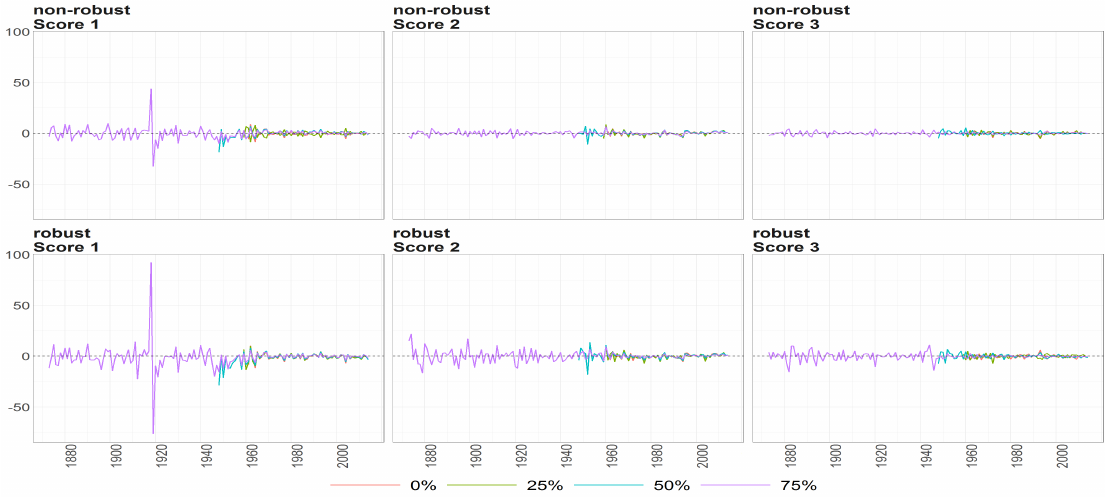
Figure 15. The scores (y axis) over time (x axis) obtained using PPCA for female population of Life Expectancy at Birth. Colours of lines correspond to the scores calculated on subsample where are different levels of maximum missing values per observation (0%, 25%, 50% and 75%, refer to legend). The plots placed in the first row correspond to the results using non- robust standardization of entry data, where the second row correspond to robust standardisation. The plots of scores are ordered by columns.